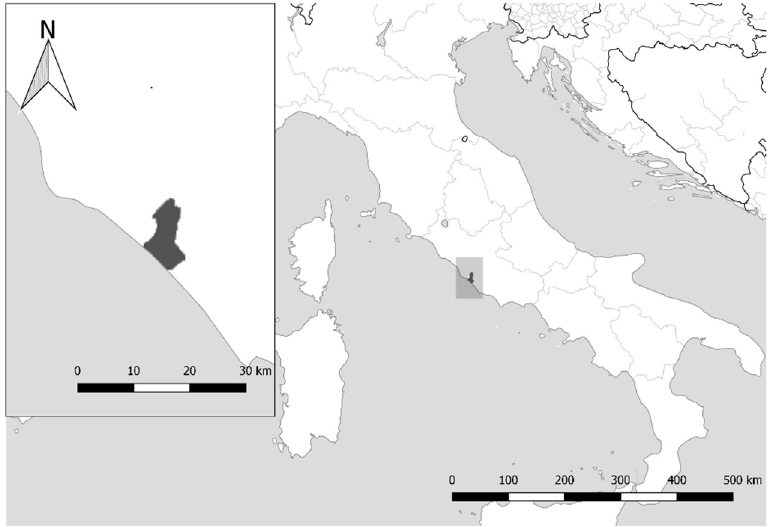
Figure 1. Map showing the study site in Latium coast.